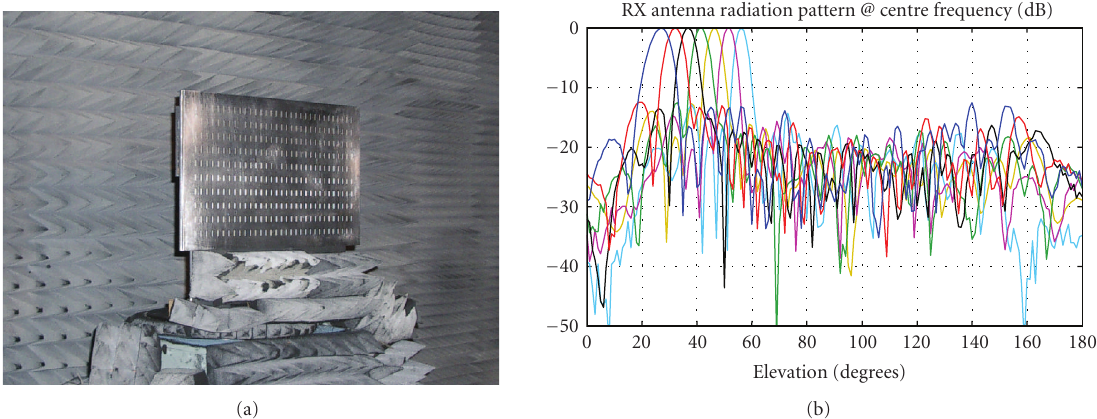
Figure 2: SAET RX prototype antenna, 32 × 10 slotted waveguide array: (a) measurement setup; (b) measured radiation patterns.